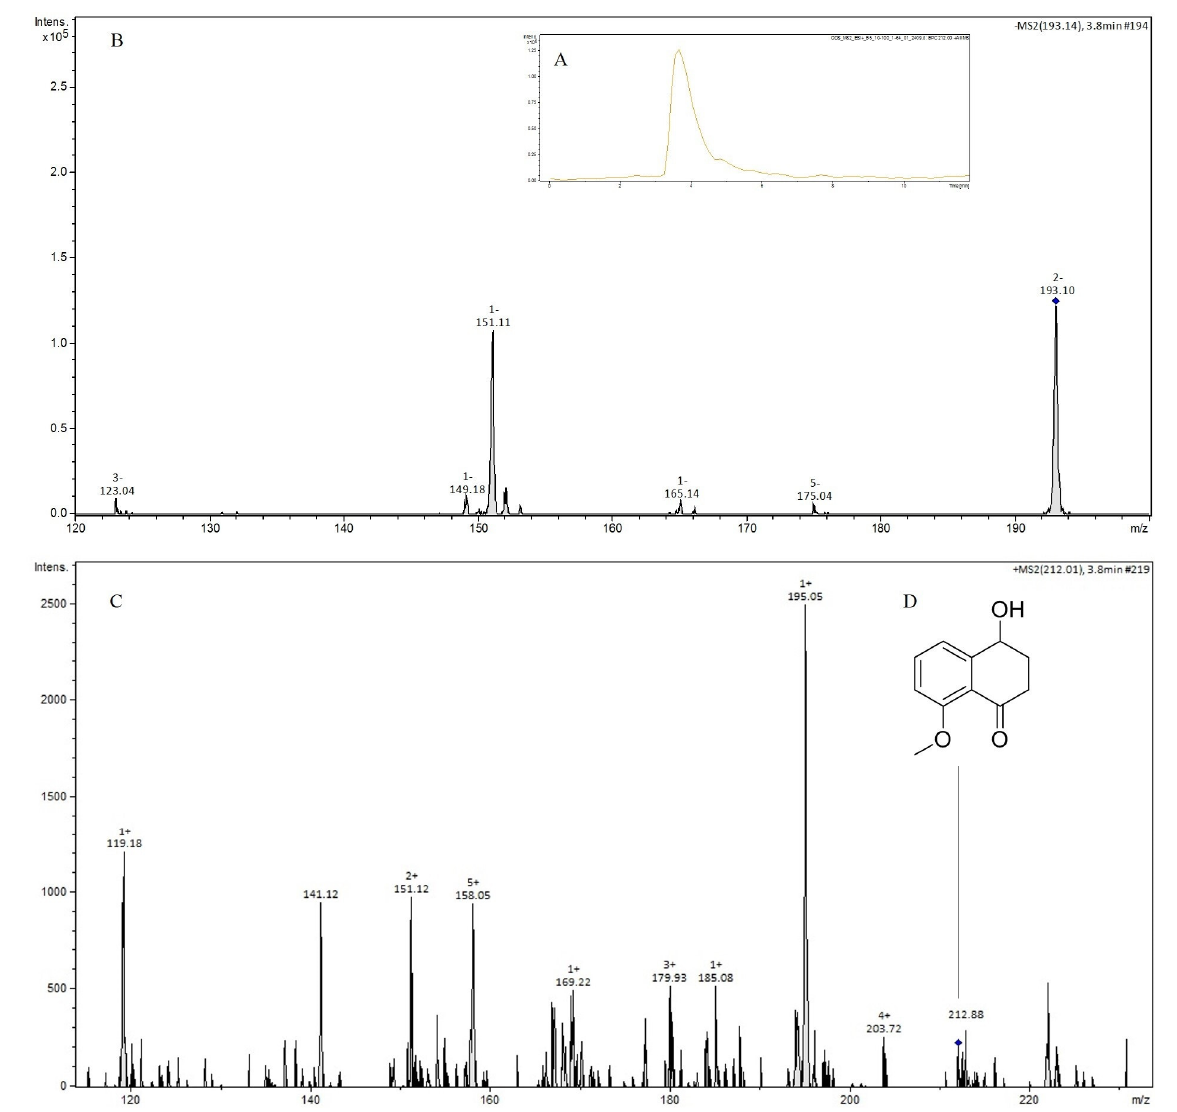
Figure A4. ( A ) Peak of the MS2 spectrum; ( B ) MS2 spectrum of [M − H] m / z 193 in negative mode; and ( C ) [M + H] m / z 212 in positive mode of compound 1 from LC-MS/MS analysis of EtOAc extract produced by A. stygium WL1B5; ( D ) Nodulisporone. The assessment was performed without replicates.